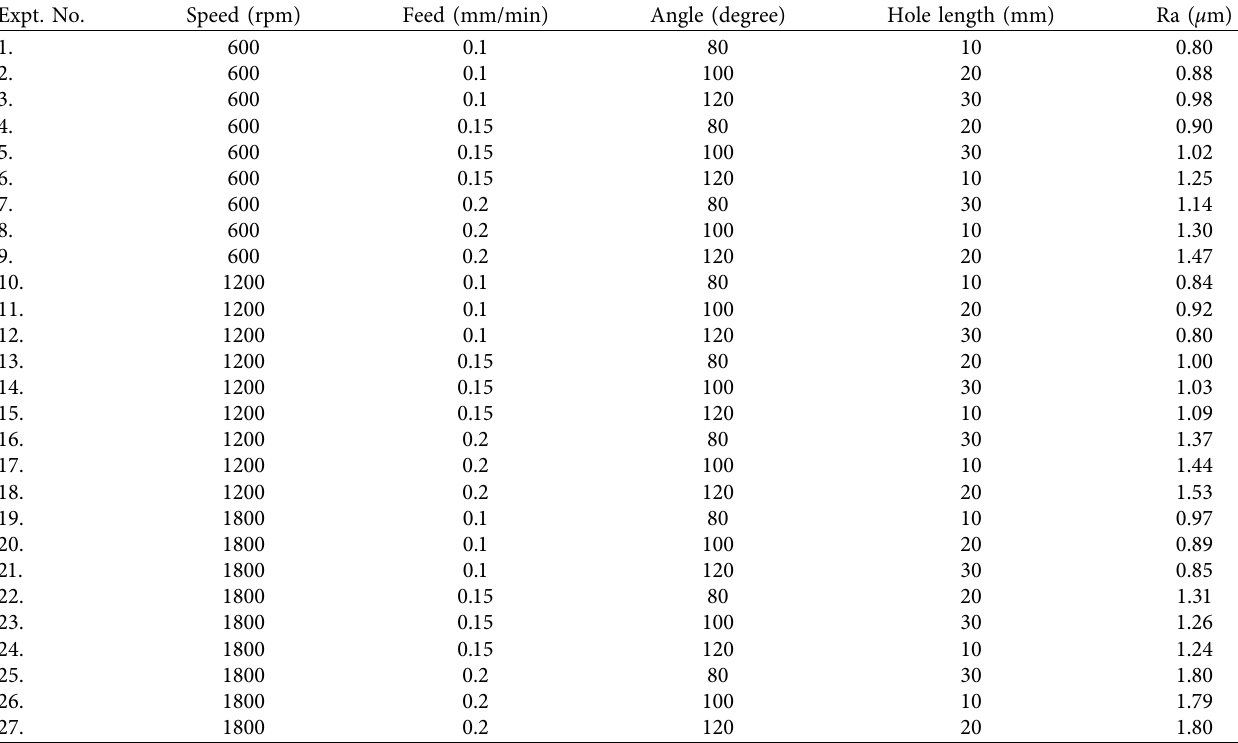
Table 1: The results obtained from the experiments.